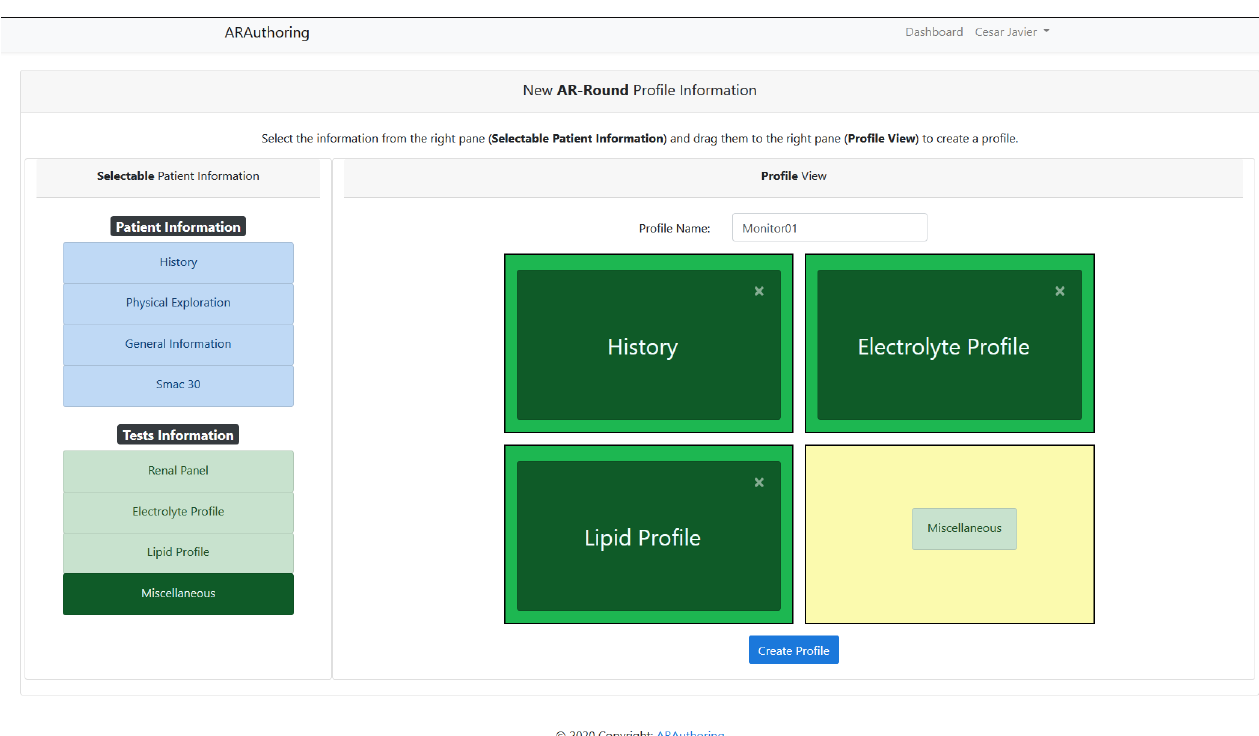
Figure 3. Administrative user dashboard page in ARSupport.